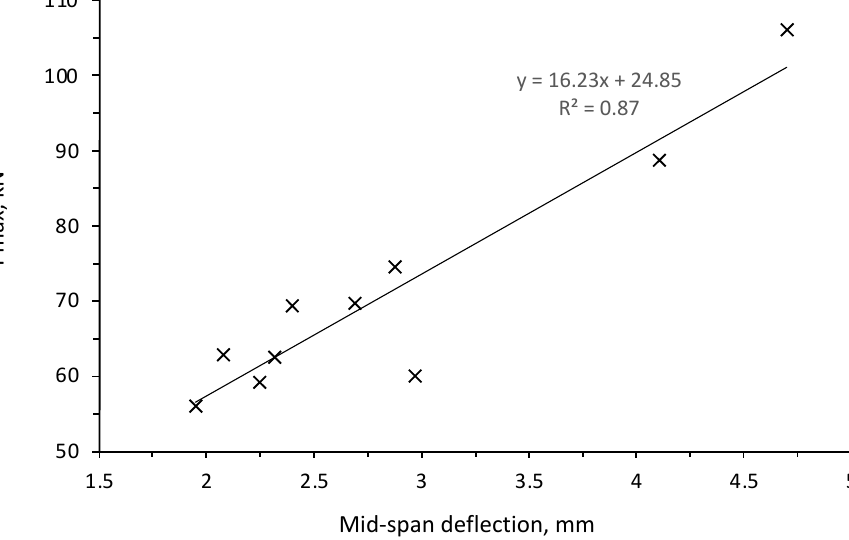
Figure 10. Relationship between P max and δ max responses for RC beams (i.e., shear testing). Effect of SBR — The P max increased from 55.97 kN for the beam containing 4.5% PET